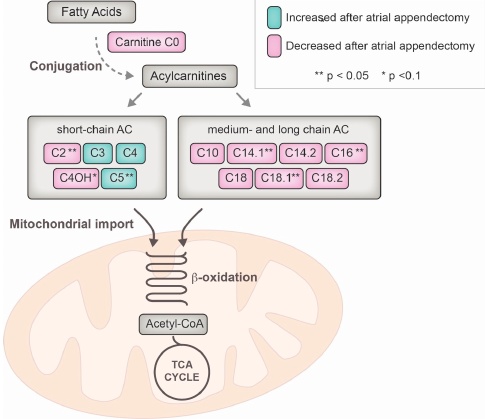
Figure 3. Metabolomic pathway of acylcarnitine utilization and influence of the left atrial appendage closure over the mid-term follow-up. ** indicate statistical significance after regression analysis ( p < 0.05), * indicates a statistical trend ( p < 0.1); AC = acylcarnitine, CoA = co-enzyme A, TCA = tricarboxylic acid.